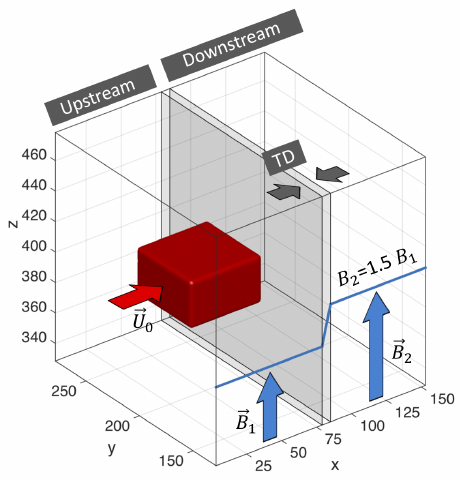
Figure 1. Schematic diagram of the simulation set-up. The high- speed plasma jet (shown by the red 3-D box) moves from the up- stream region towards a parallel tangential discontinuity. The spa- tial profile of the background magnetic field is shown in blue. The tangential discontinuity is located between x 1 = 79 and x 2 =